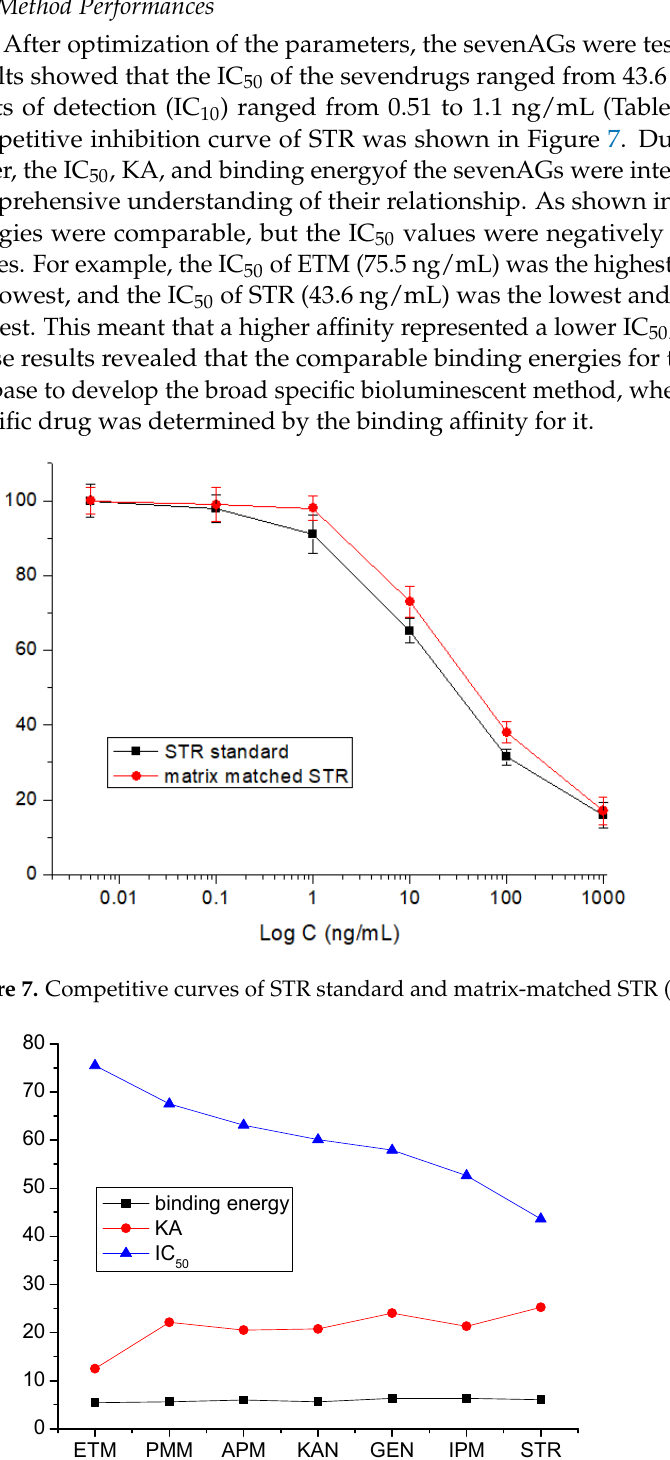
Figure 6. Results for the optimization of ( A ) the concentrations of RpsL12–Rluc and STR–BSA, and ( B ) incubation time (STR 100 ng/mL).